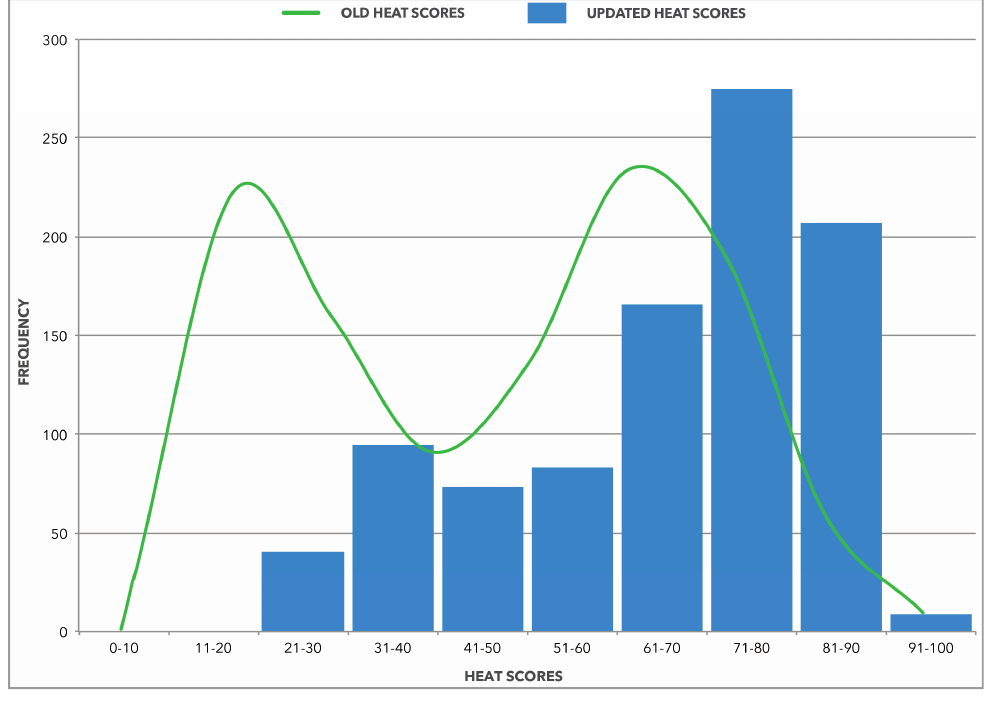
Figure 7. The distribution changed from multi-modal (green line) to negatively skewed uni-modal (blue bars) after HEAT Scores were calculated for verified